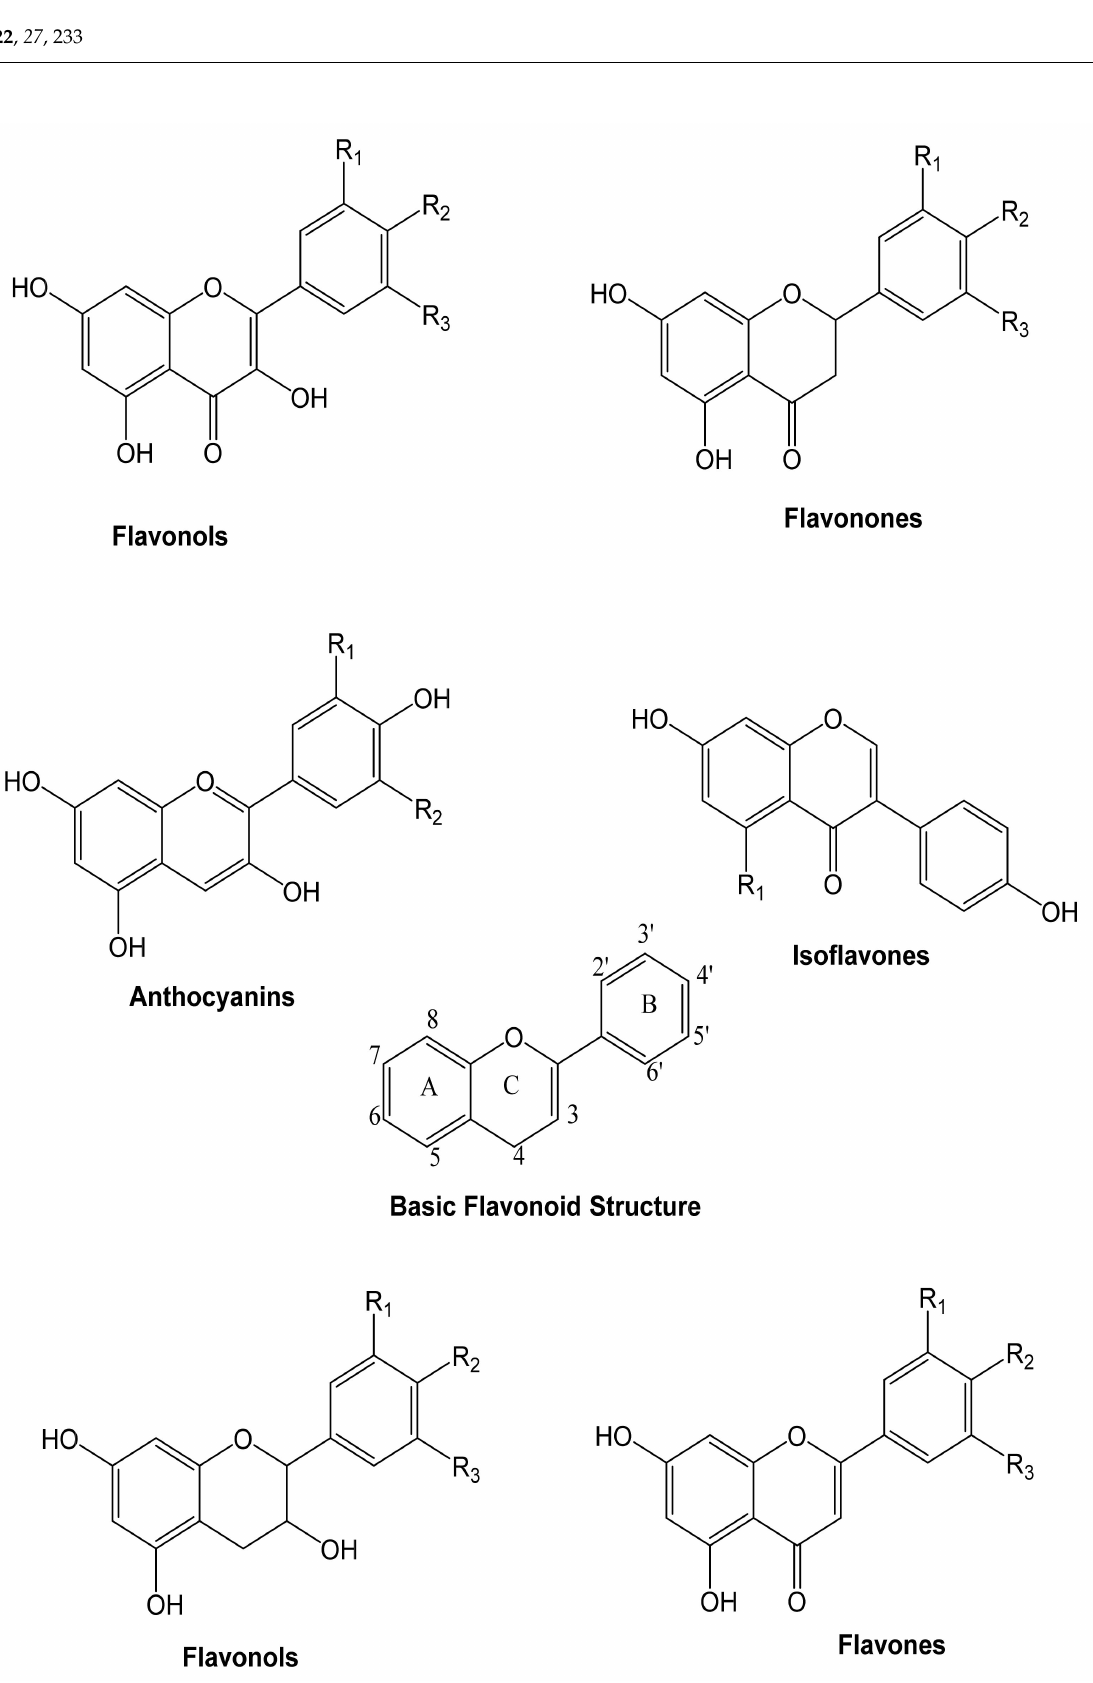
Figure 3. The general structure of the principal groups of flavonoids